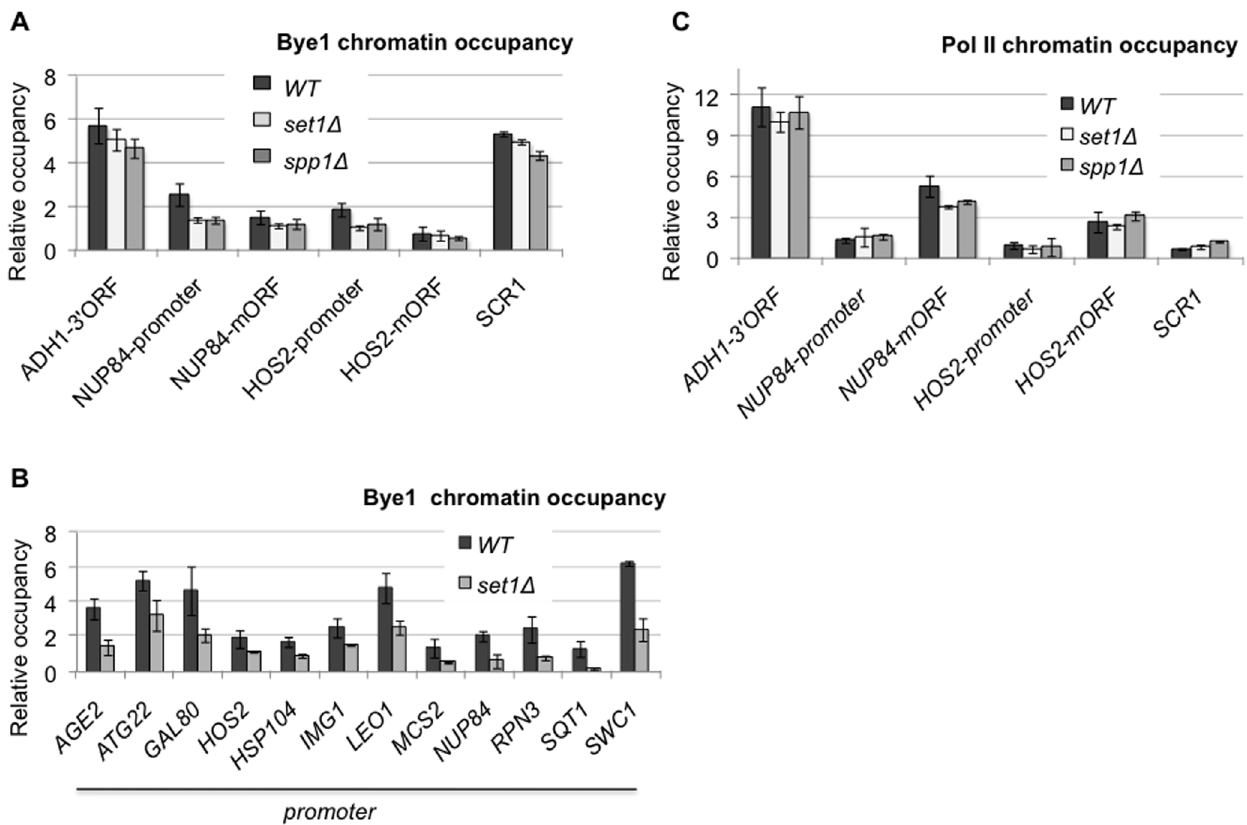
Figure 4. Bye1 association with promoters of class II genes requires H3K4me3: (A, B) Quantification of Bye1-Myc enrichment in WT and strains deleted for SET1 or SPP1 genes relative to the intergenic region by ChIP; (C) Quantification of Rpb1 enrichment in WT , set1 D and spp1 D strains relative to the intergenic region by ChIP. 3 9 ORF and mORF stand for the 3 9 end and middle coding regions.